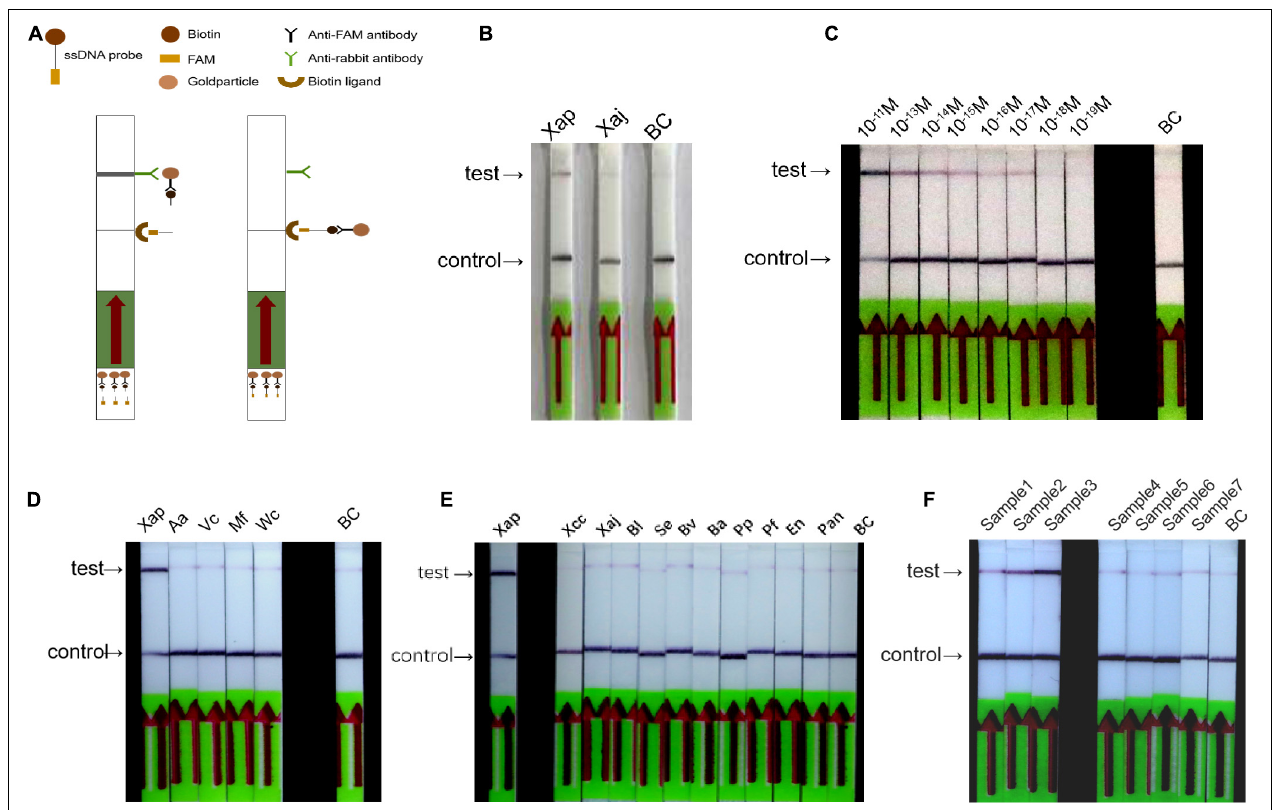
FIGURE 4 | The RPA/Cas12a-LFA assay. (A) Schematics of RPA/Cas12a-LFA assay. (B) The preliminary establishment of the RPA/Cas12a-LFA system. (C) Sensitivity of the RPA/Cas12a-LFA assay. (D,E) Specificity of the RPA/Cas12a-LFA assay. (F) Field detection of the RPA/Cas12a-LFA assay. BC, blank control.